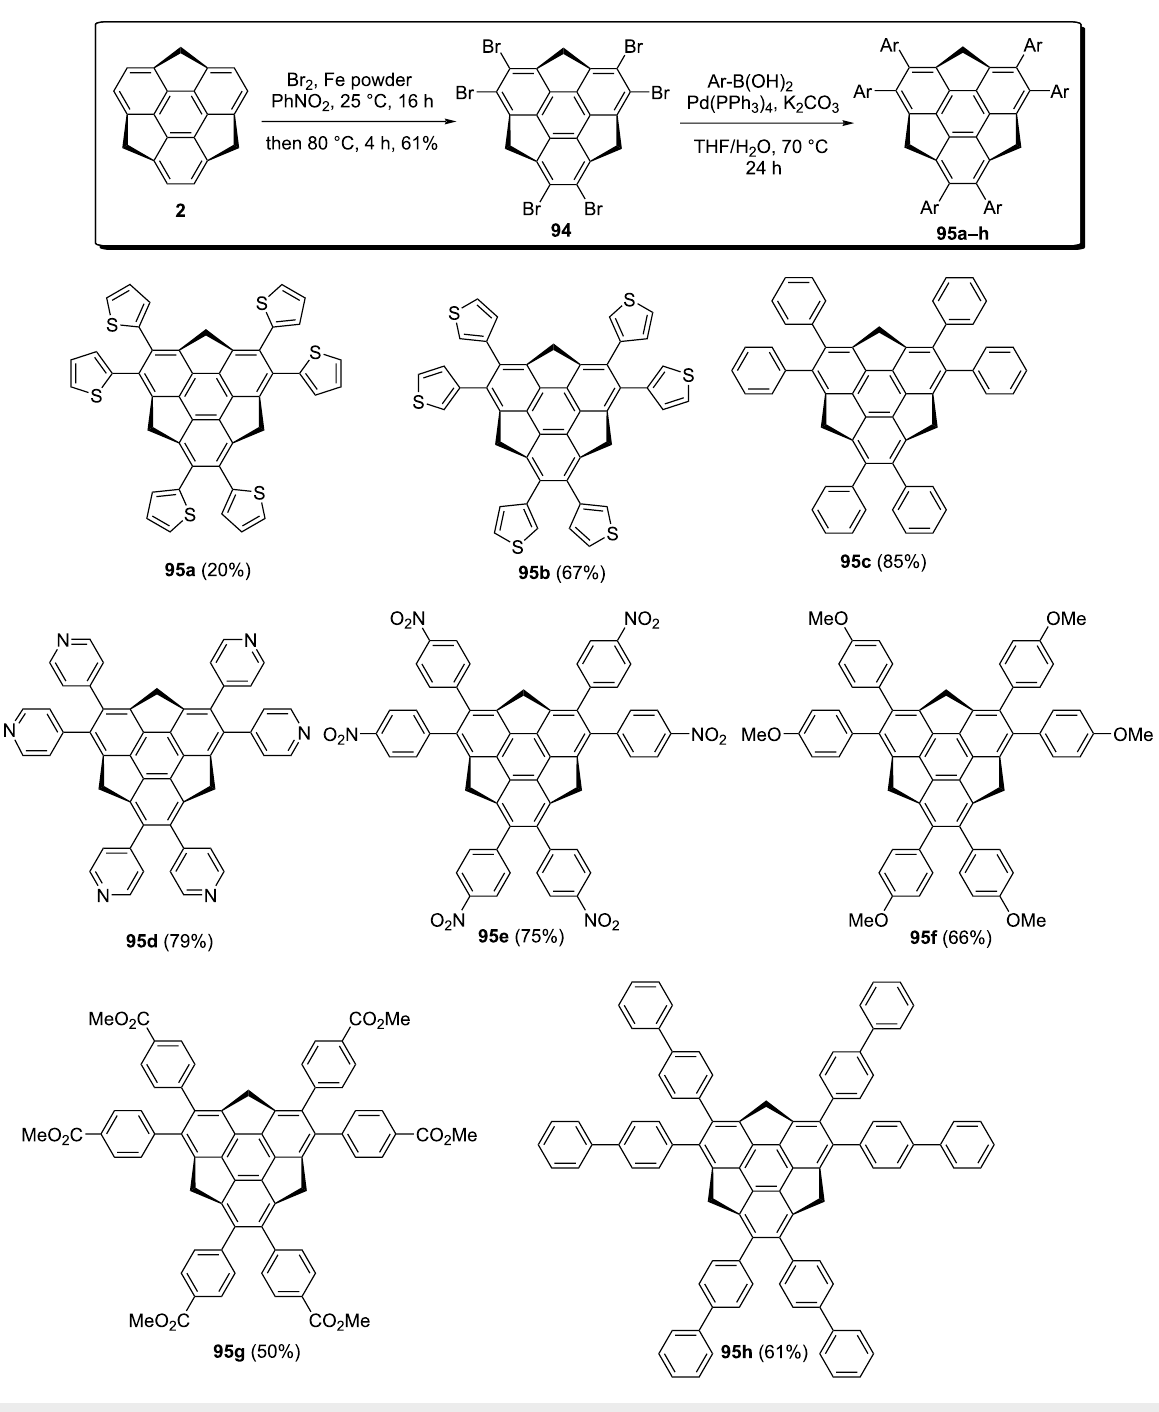
from syn -tris(oxonorborneno)benzene 23 , obtained via palla- dium-catalyzed cyclotrimerization of iodonorbornene. The C 3 -symmetric compound 23 was then converted into the methy- lene groups containing compound 103 using Wittig reaction which on further treatment with dimethyldioxirane